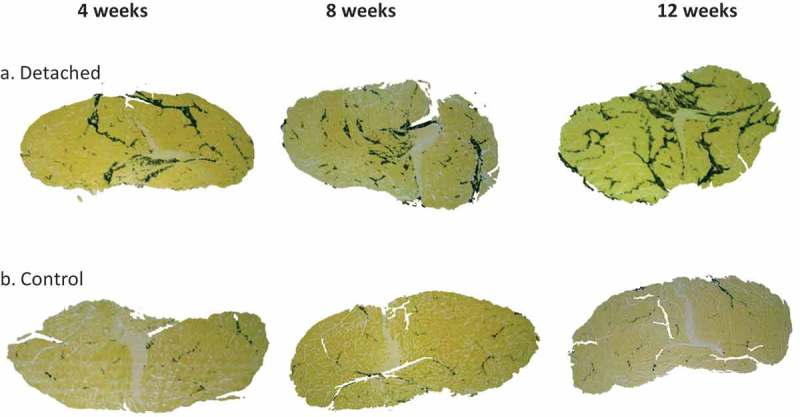
Representative micrographs of IMF accumulation in the distal quarter of the SSP muscle cross-sections. (a). SSP muscle sections at 4, 8 and 12 weeks after tendon detachment. (b). SSP muscle sections in control animals at the same time points. IMF was stained using osmium tetroxide and is visible at black-stained areas. Note the higher accumulation of fat in the tendon detached group compared to controls at all time points studied. Original magnification at 6.7x.